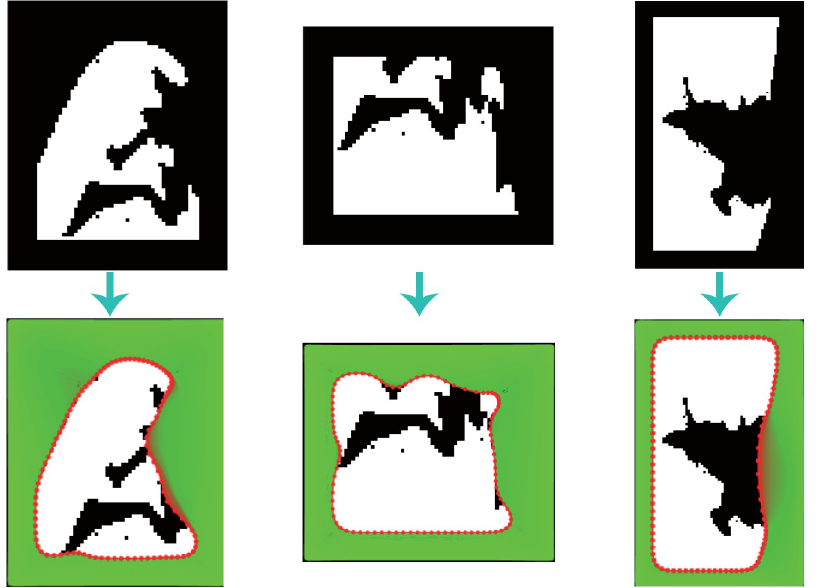
Fig 11. The correction effect of three local areas.